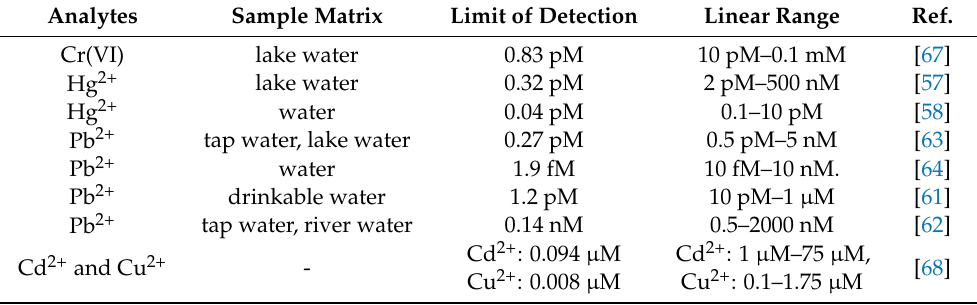
Table 2. Brief summary of ECL biosensors for heavy metal ion sensing in